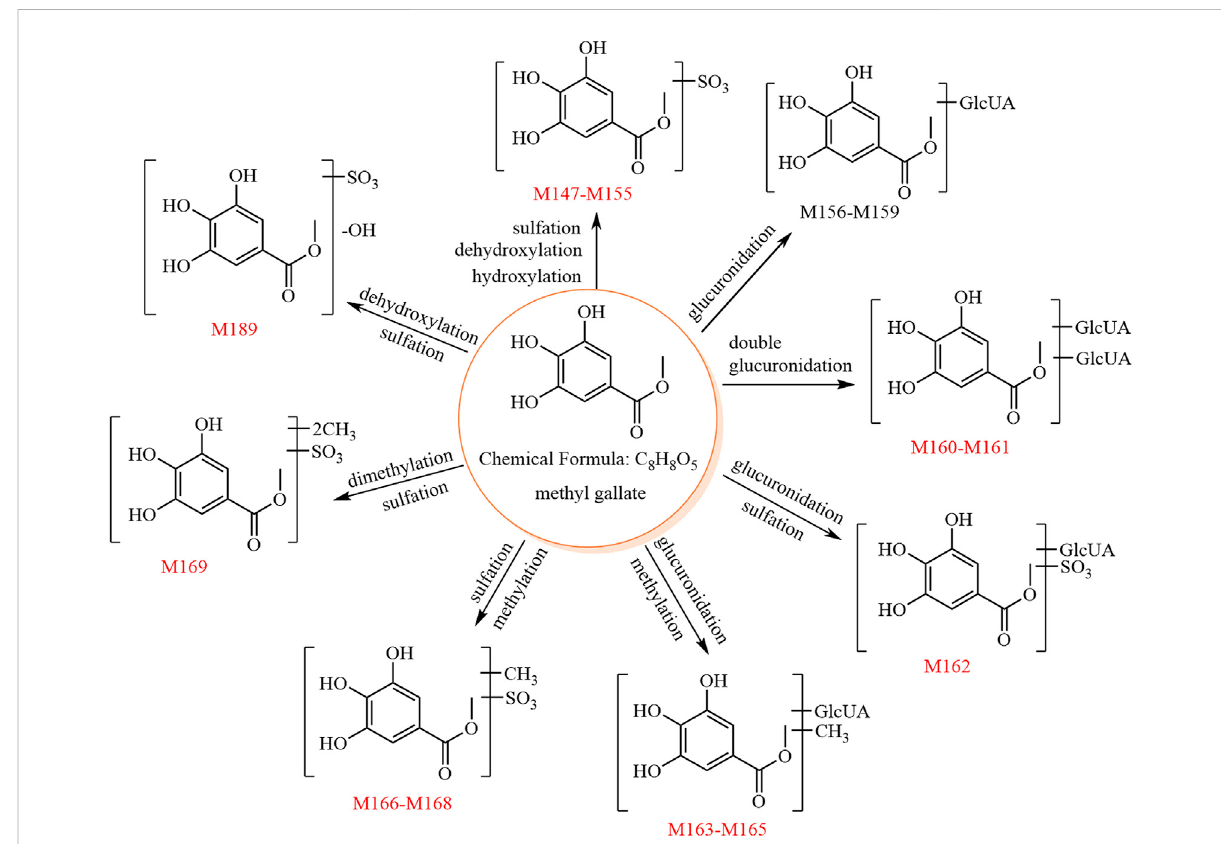
FIGURE 4 The 24 metabolites and proposed metabolic pathways of methyl gallate in mice. The red numbers denote new metabolites.